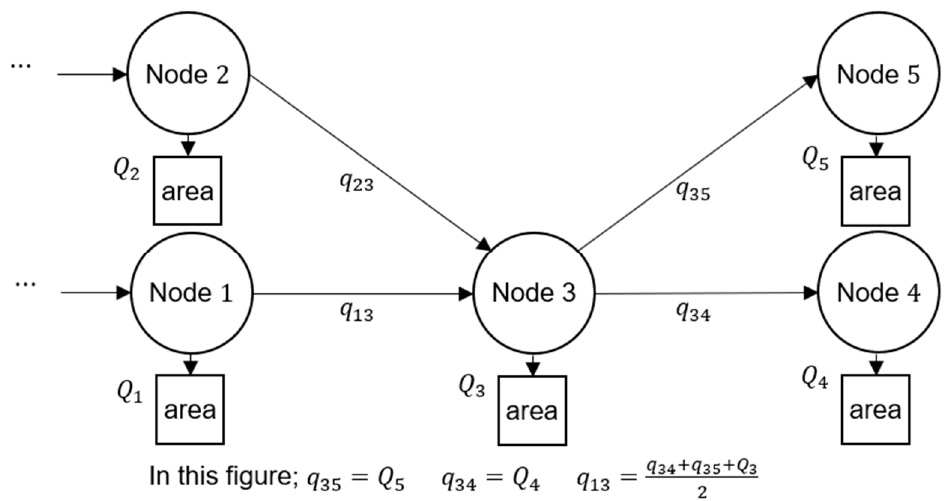
Figure 2. Sample calculation of the amount of water flow. Arrows, circles, and squares indicate the water flow, nodes, and areas where water is supplied, respectively. The lowercase “q” and uppercase “Q” indicate the amount of water that will be carried by each pipeline and that will eventually be supplied to each area, respectively.